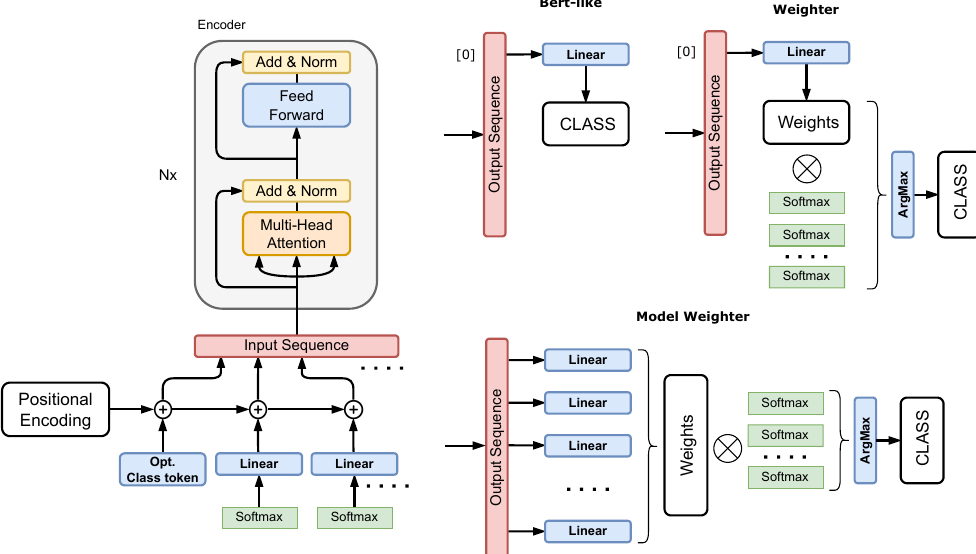
Figure 2. Different types of neural ensemblers. The backbone is a standard Transformer encoder with an optional class token. The rest of the input sequence are the embedded softmax vectors of models to be ensembled for a given video sequence. The output of the encoder has the same length as the input sequence. Bert-like decoder uses a class head to predict the final class from the class token. Bert-like weighter uses the class token to decode the weights for individual models. Model weighter , on the other hand, does not use a class token, but decodes individual sequence elements into a scalar weight that is then used to compute the weighted